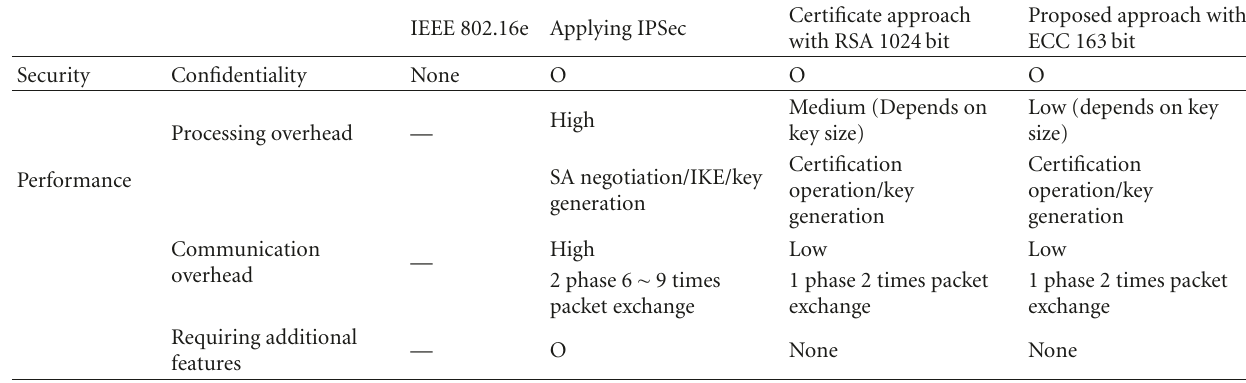
Table 2: Security and performance analysis in access network.